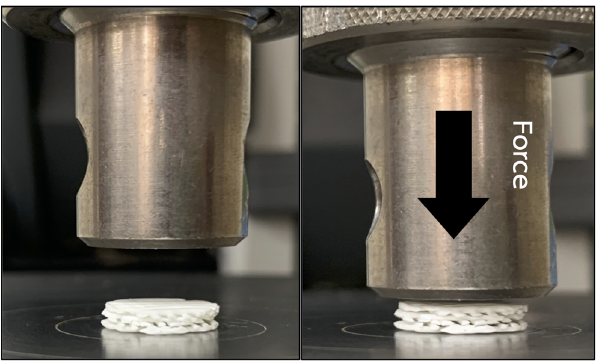
Figure 2. The mechanical testing was performed by applying compression force (arrow) onto the superior aspect of the